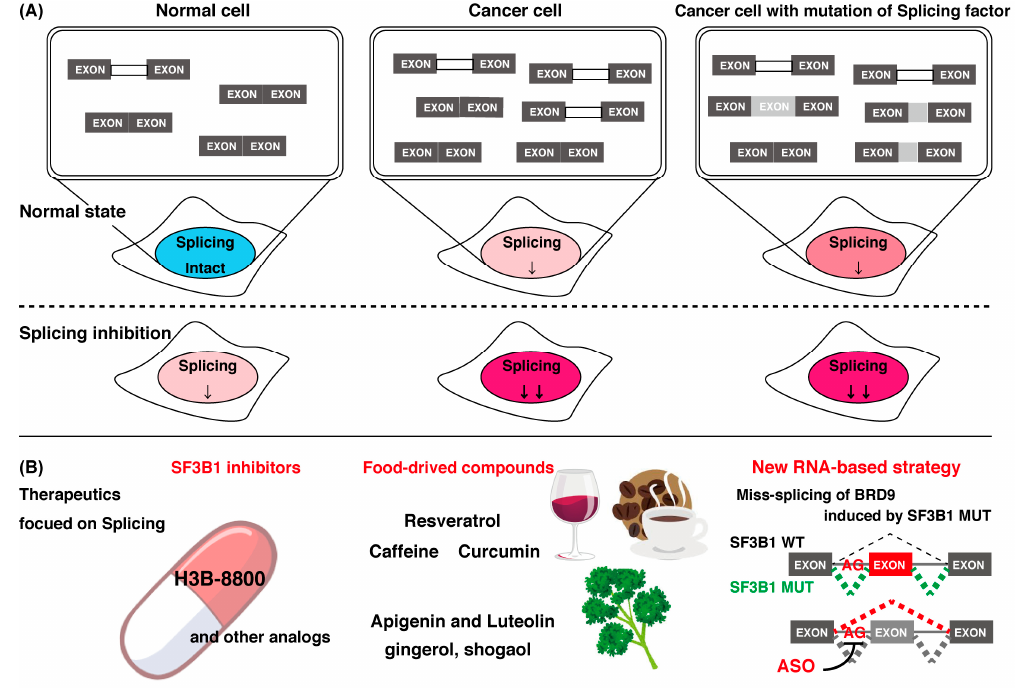
Figure 3. Availability of compounds with splicing inhibition activities. ( A ) E ff ects of splicing inhibitors on normal cells, cancer cells, and cancer cells with mutations in splicing factors. Cancer cells have more transcripts than normal cells, resulting in splicing stress. In addition, cells with mutations in the splicing factor cause splicing abnormalities. These splicing factor mutations are heterozygous, suggesting that wild-type splicing factors have an essential role in cell survival in these cancers. Cancer cells with or without splicing factor mutations are, thus, more sensitive to splicing inhibition than normal cells. ( B ) The anti-cancer e ff ect of various splicing inhibitions. SF3B1 inhibitors, such as H3B-8800, are anticipated for clinical use. Food-derived compounds with similar splicing inhibition activity were also reported to have anti-cancer e ff ects, and they are expected to have cancer-preventing e ff ects. In addition, inhibition of mis-splicing on BRG9, which is widely observed in cancers with an SF3B1 mutation, using antisense oligonucleotides (ASO) is expected to be a new strategy for cancer